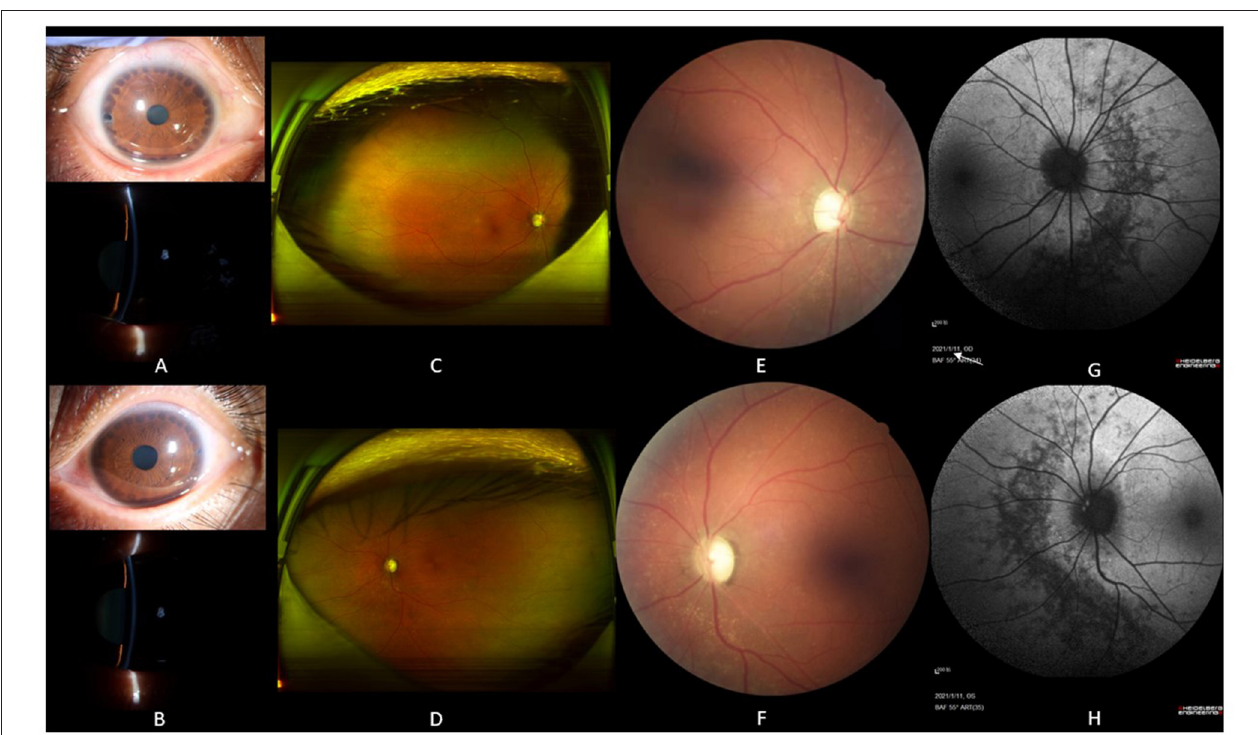
FIGURE 1 | The slit lamp photos and fundoscopy for the proband. Slit lamp photos of the proband showed peripheral iris foramen after laser peripheral iridoplasty in both eyes [upper picture in (A,B) ] and shallow anterior chamber [lower picture in (A,B) ]. SLO presented plenty of scattered yellowish-white spots on the whole retina, and there was no bone spicule-like pigment clumping in the retina for both eyes (C,D) . Color fundus photography displayed enlarged cup-to-disc ratios ( ∼ 0.95 for both eyes) and plenty of yellowish-white spots around the optic disc (E,F) . Fundus autofluorescence demonstrated decreased autofluorescence with scattered increased autofluorescence (G,H) . There were optic nerve drusen showed increased autofluorescence in the left eye [white arrow in (H) ], and annular increased autofluorescence around the optic disc in the left eye (H)